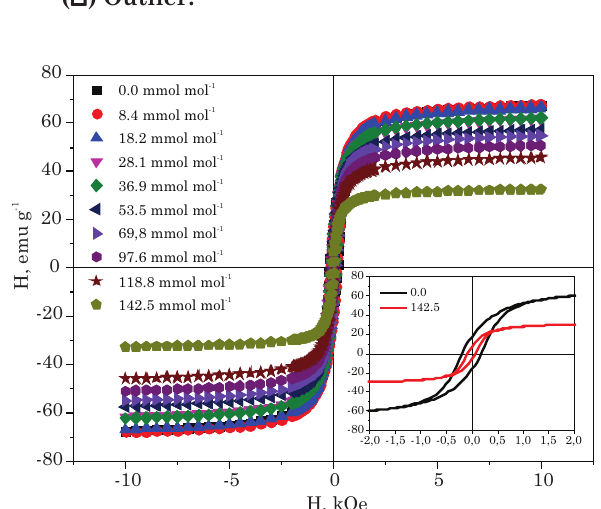
Figure 5. Magnetic hysteresis loops for γγγγγ -Fe 2-x Al x O 3 samples at RT; Insets: 0.0 and 142.5 mmol mol -1 Al-substituted